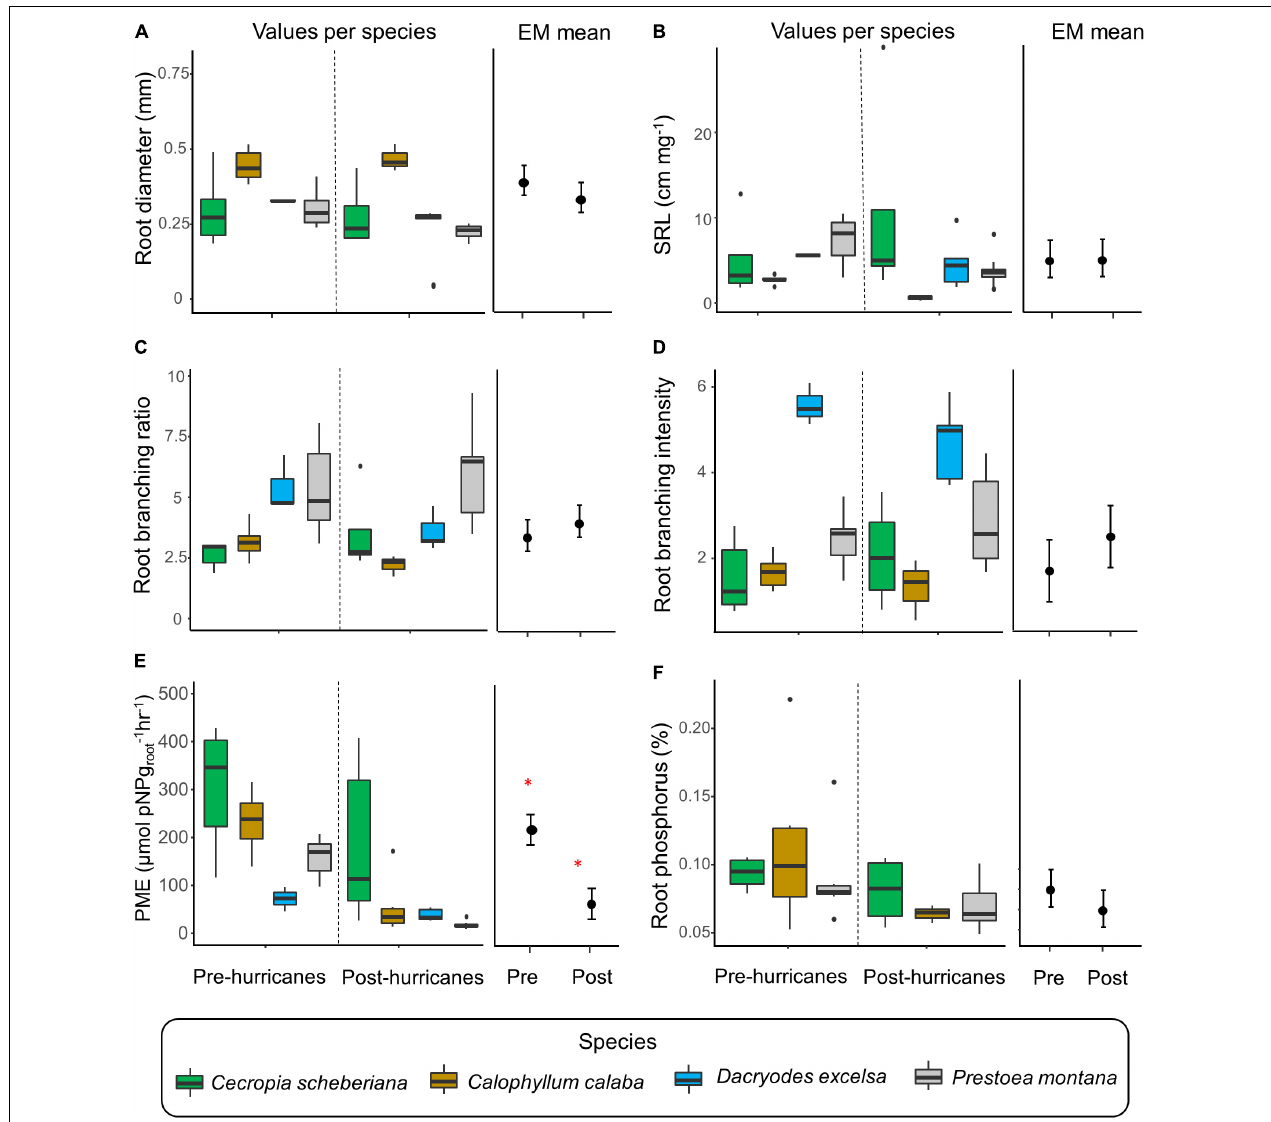
FIGURE 5 | Fine-root trait values for four common trees species at the Luquillo Experimental Forest in Puerto Rico before and after two consecutive hurricanes (boxplots on the left of each panel). We fitted linear mixed-effects models with tree within species within sites as a nested random effect and report the estimated marginal means (EM means; right plot of each panel) and standard error of the means for each root trait. (A) Root diameter and (B) specific root length (SRL) were measured from 1 st root order. (C) Root branching ratio, (D) root branching intensity, (E) root phosphatase activity (phosphomonoesterase; PME), and (F) root phosphorus concentration were measured from 1 st and 2 nd orders combined. Significant differences in (mean) root trait values before and after the hurricanes are marked with a red asterisk. Due to sampling restriction, root phosphatase activity (phosphomonoesterase; PME) was not measured for Spathodea campanulata and root phosphorus concentration was not estimated for Dacryodes excelsa